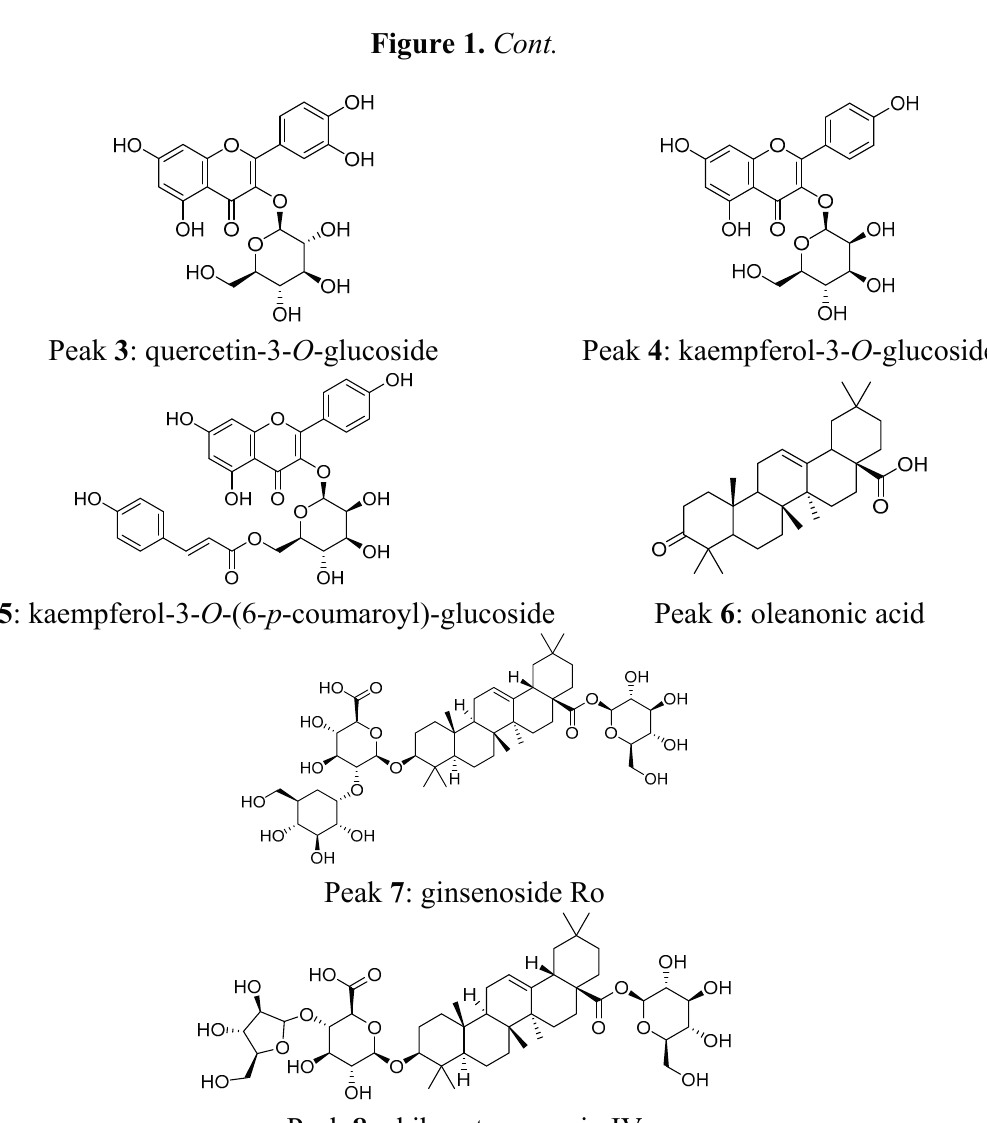
Peak 8 : chikusetsusaponin